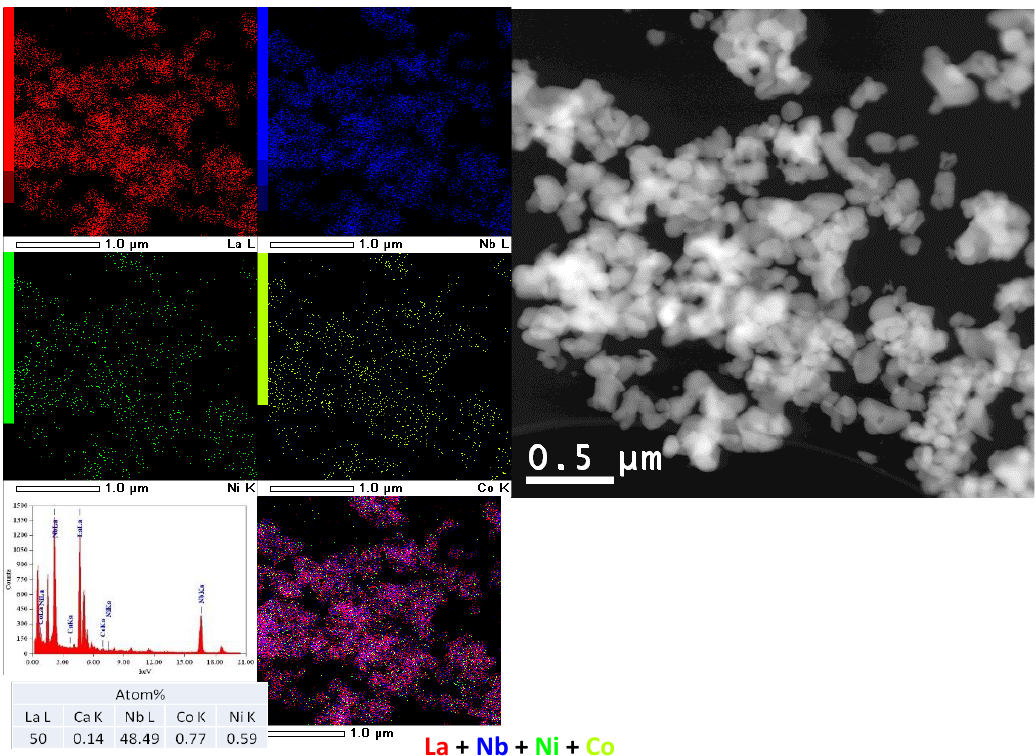
Figure 7. HAADF-STEM image with EDX analysis of La 0.99 Ca 0.01 NbO 4 /NiCoO x .